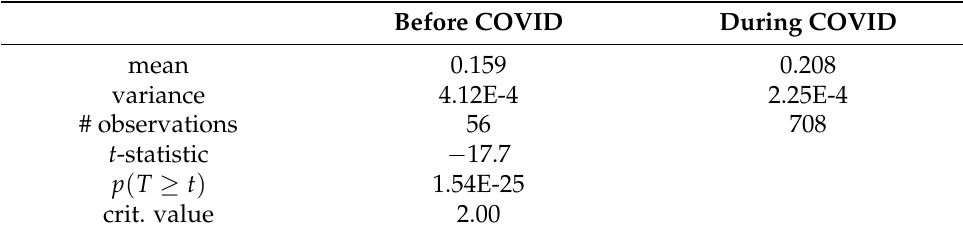
Table 3. Results of the Welch’s t -Test for Fraction of Trips Along Lines.